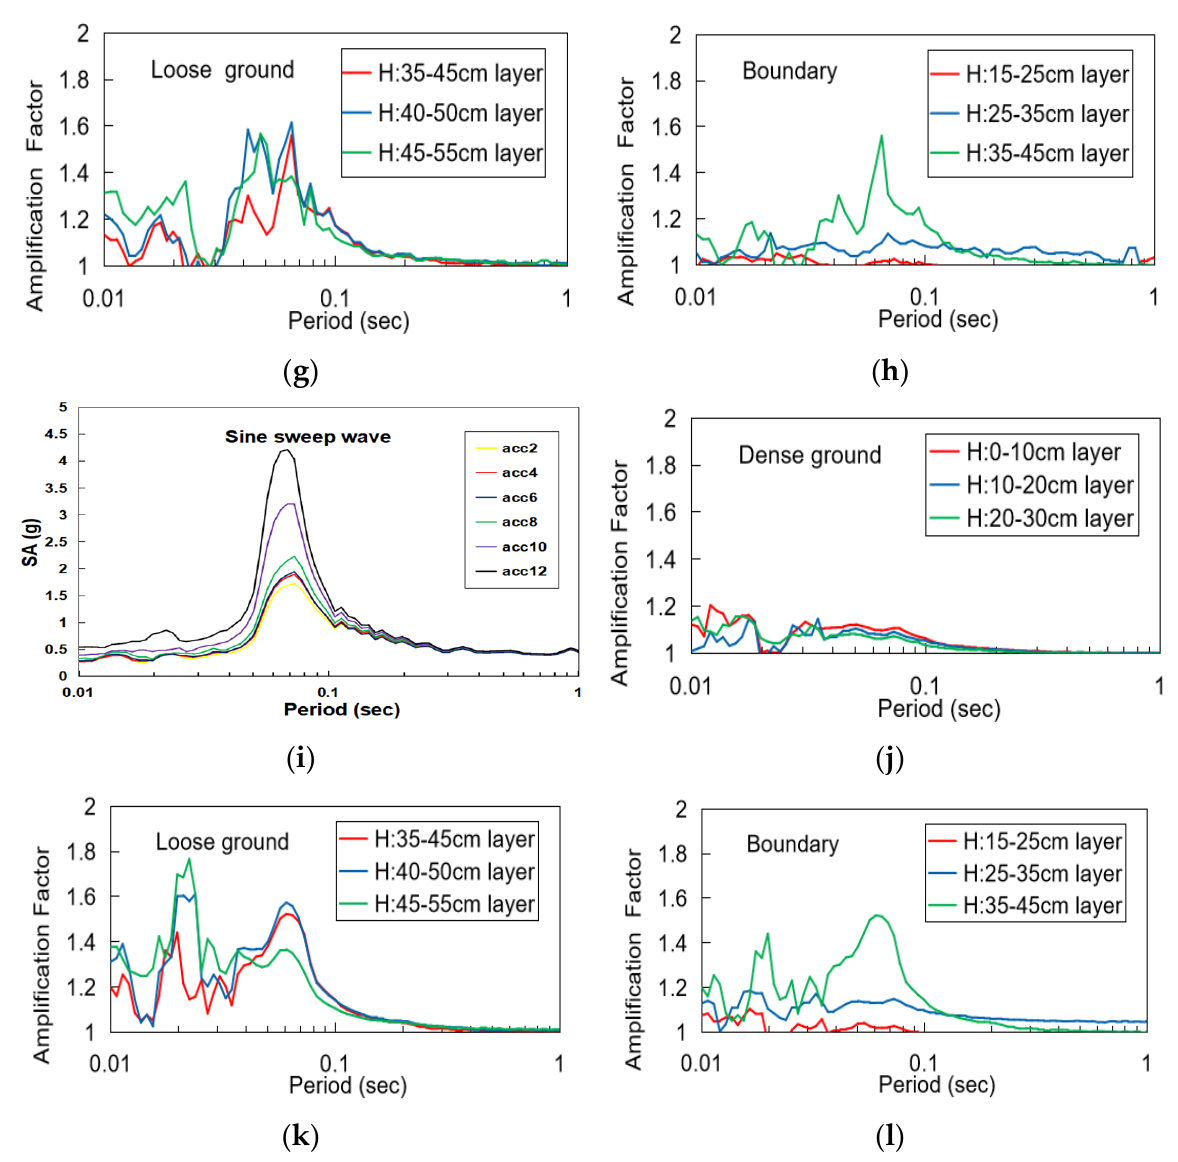
Figure 11. Spectral response acceleration for measured ground motion at different depths: ( a ) SA by sine 10 Hz; ( b ) AF of dense ground by sine 10 Hz; ( c ) AF of loose ground by sine 10 Hz; ( d ) AF of boundary ground by sine 10 Hz; ( e ) SA by artificial wave; ( f ) AF of dense ground by artificial wave; ( g ) AF of loose ground by artificial wave; ( h ) AF of boundary ground by artificial wave; ( i ) SA by sine sweep; ( j ) AF of dense ground by sine sweep; ( k ) AF of loose ground by sine sweep; ( l ) AF of boundary ground by sine sweep.